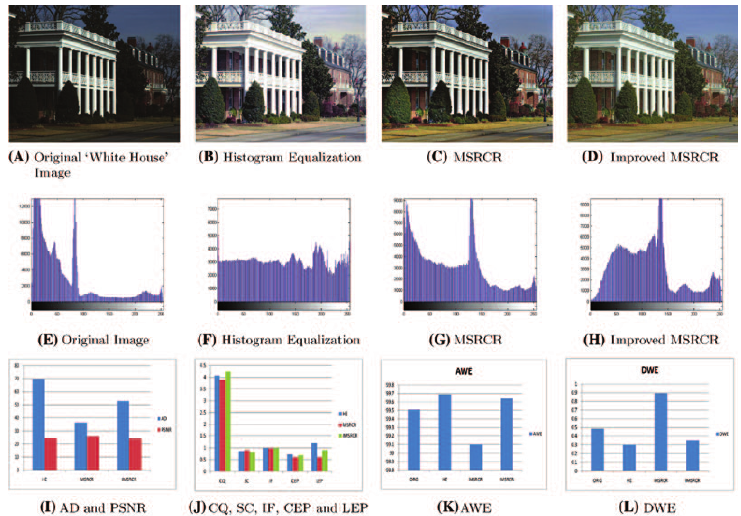
Figure 3. (Top) Image Enhancement Methods. (Middle) Histogram Plots: x -axis, Intensity Levels Ranging from 0 to 255; y -axis, Total Number of Pixels. (Bottom) Conventional Metrics and Proposed AWE and DWE Metrics. The “White House” Image has been Downloaded from